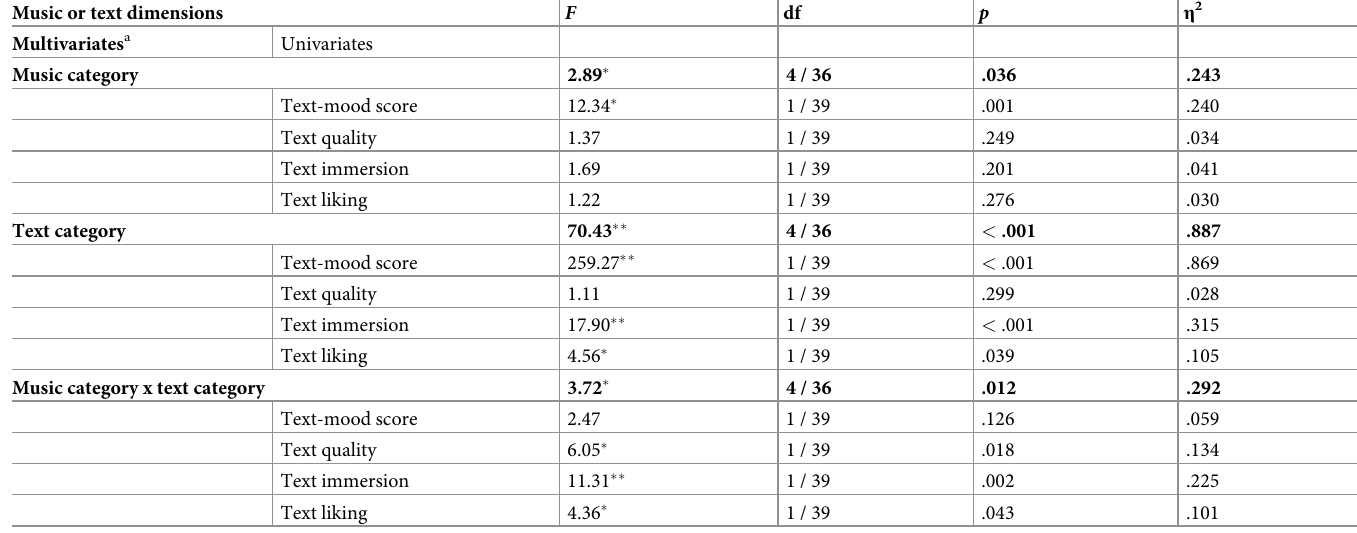
Table 1. Results of a 2 (music category) x 2 (text category) rmMANOVA on perceived mood score, quality, immersion, and liking of the text. Multivariate and uni- variate main effects and